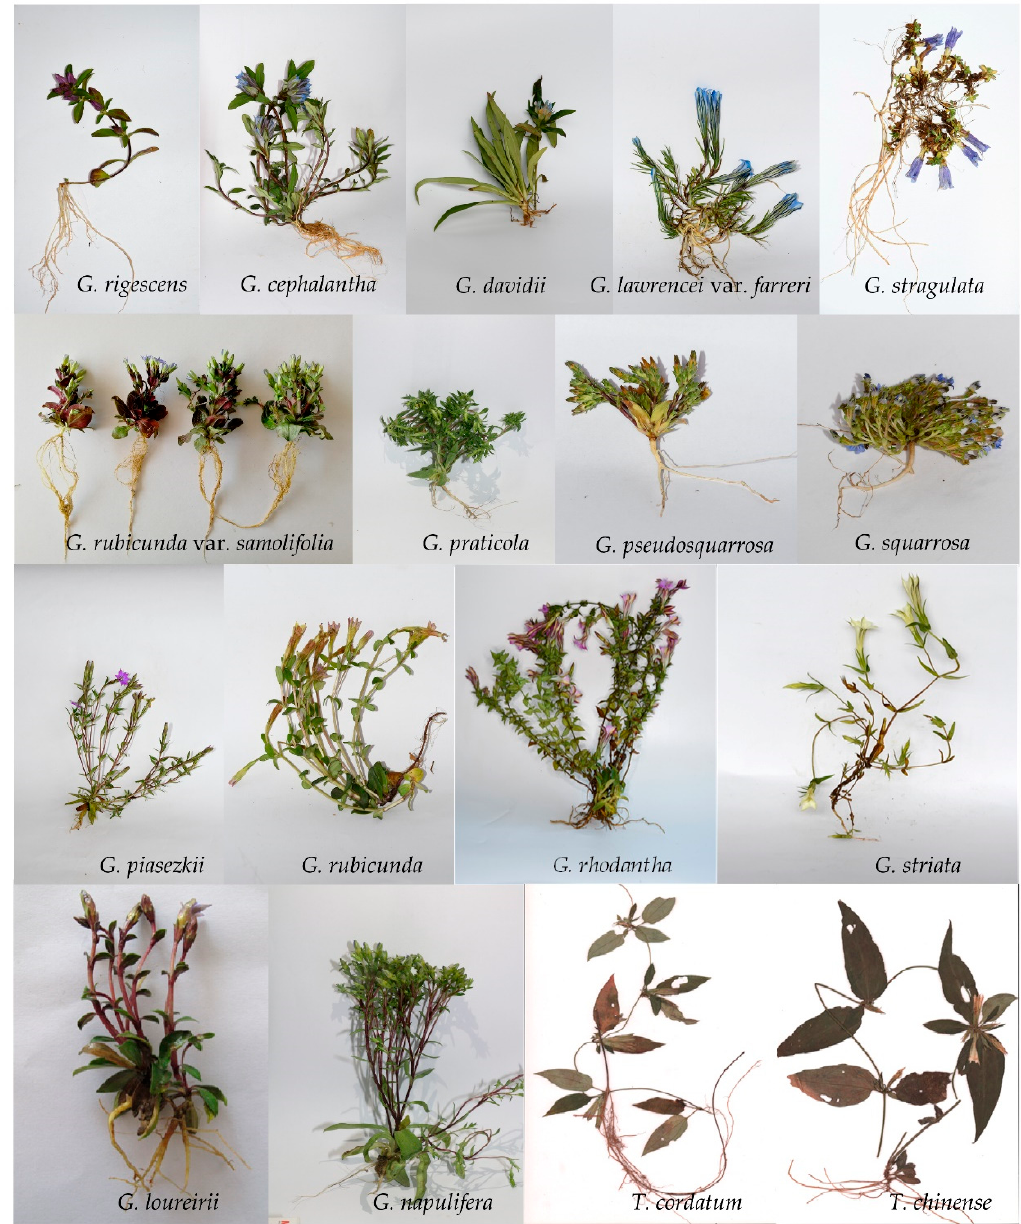
Figure 11. Medicinal Gentiana and its relatives in the study. Table 12. Sample information including their application in southwest of China.